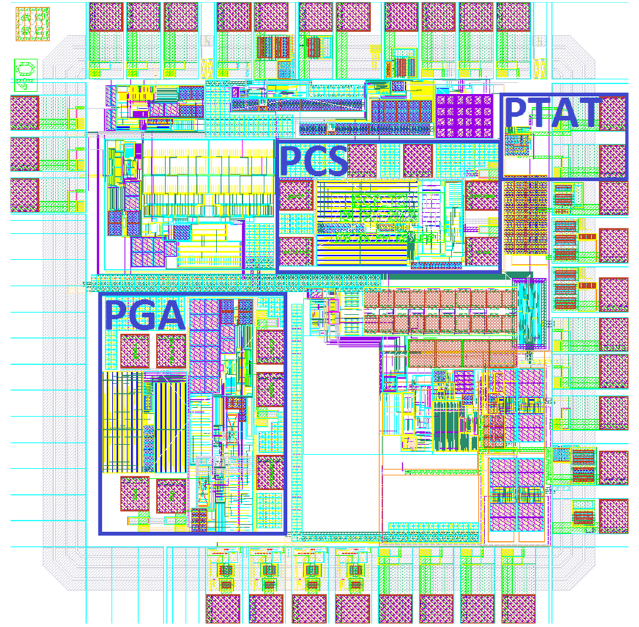
Figure 20. Test chip layout.